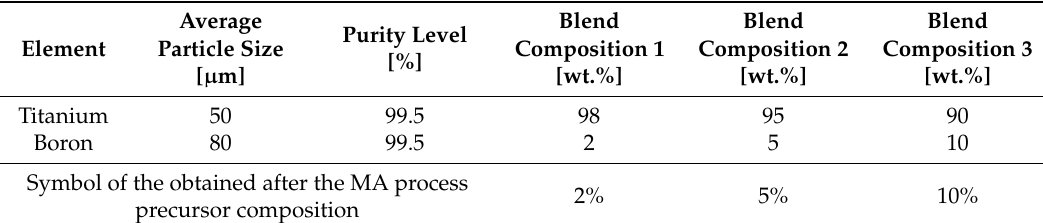
Table 1. Basic information about the starting element powders with the proposed precursor blends compositions and their